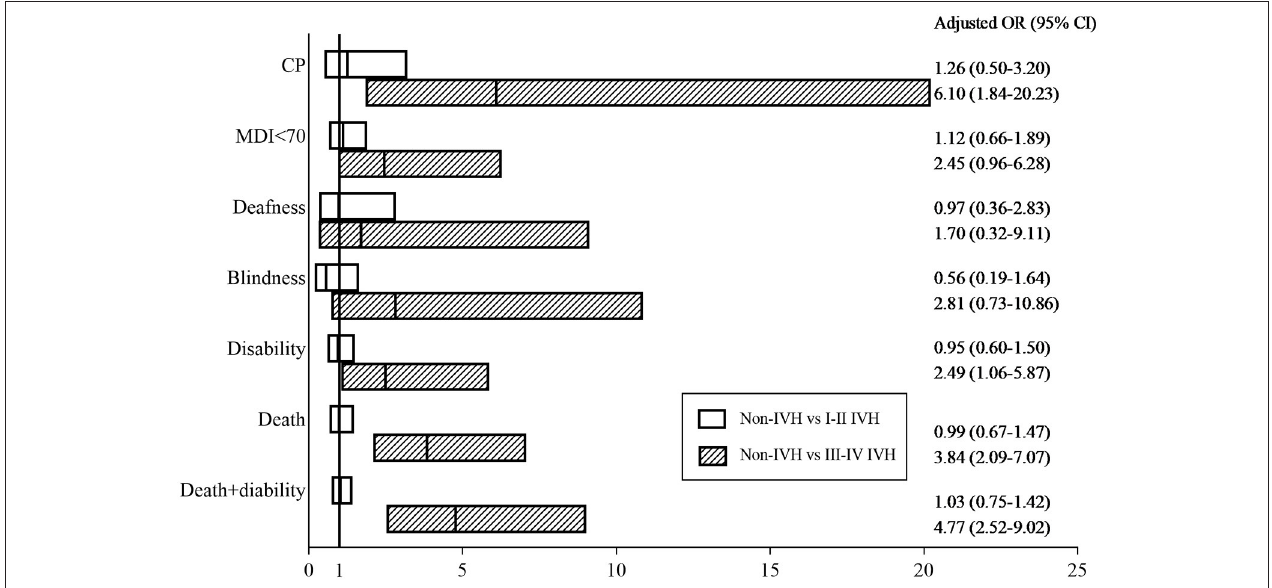
FIGURE 3 | Adjusted odds ratios. Adjusted odds ratios for death and neurological outcomes between the IVH (I-II IVH or III-IV IVH) groups and the non-IVH group at 18–24 months of corrected age. The Hosmer–Lemeshow Test was used to test the goodness-of-fit of the model.